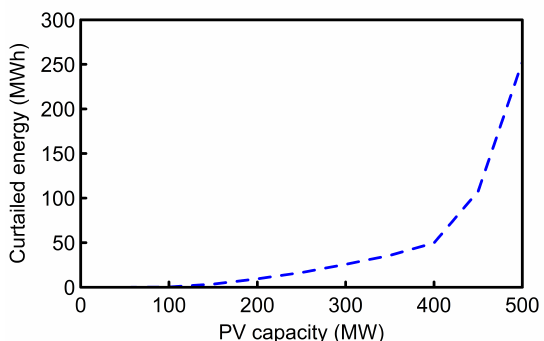
Figure 9. Curtailed energy solar energy for example day. In order to limit over-generation, an expo- nential increase in the total solar PV power curtailed can be observed.